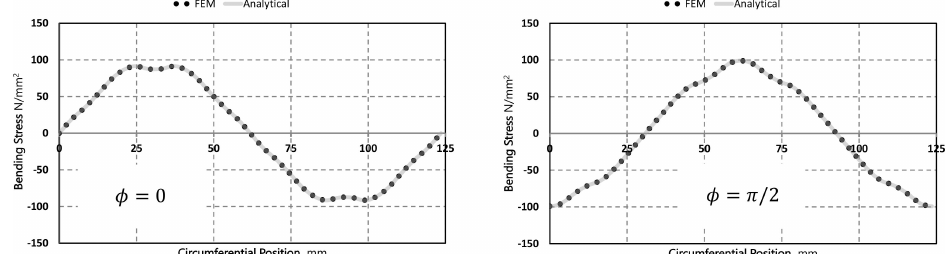
Figure 12. Distribution of the bending stresses on the M-T04 profile for two rotation angles: FEM results and analytical solution based on Equation